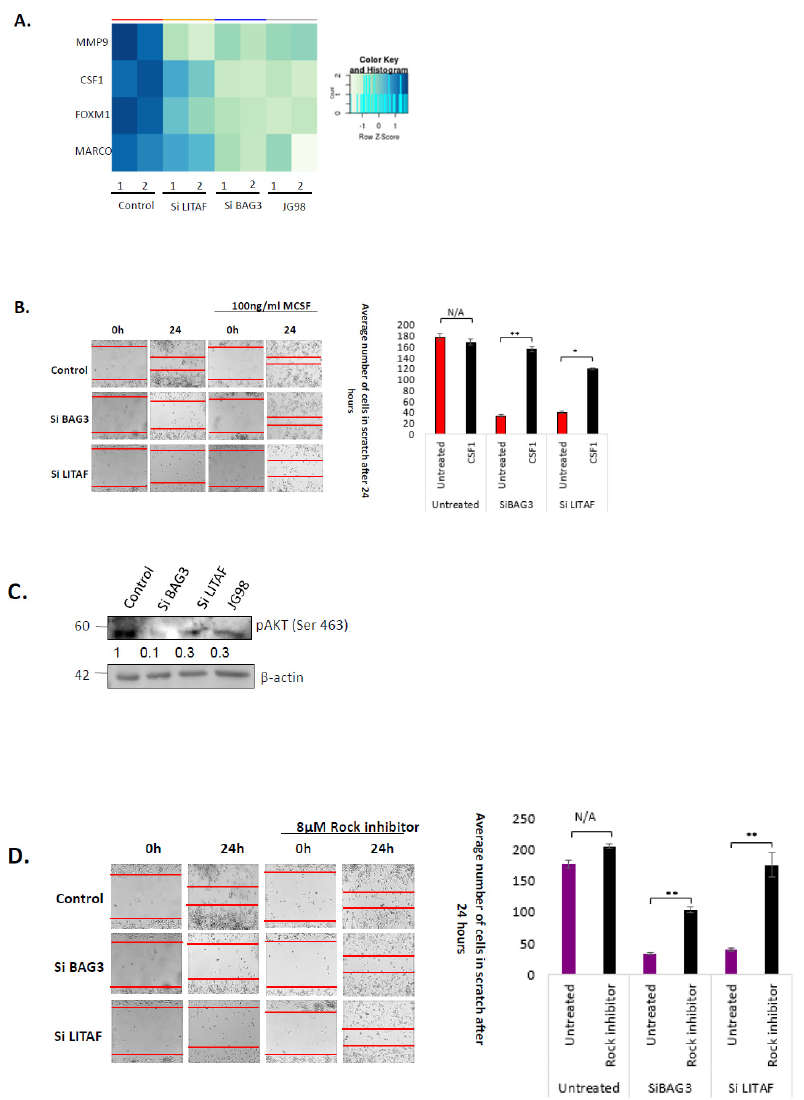
Figure 5. Effects of Bag3 and LITAF on macrophage motility are mediated by CSF1. ( A ) Effects of silencing of Bag3 or LITAF or inhibition of Hsp70 on the expression of motility-related genes. RNA was isolated from macrophages that were treated with siBAG3, siLITAF, control siRNA, or 5 µ M JG98, and gene expression was assessed by RNAseq. Genes related to motility/migration are shown. The figure presents data from two independent experiments. Color coding shows a False Discovery Rate (FDR). ( B ) The addition of CSF1 significantly restores cell motility upon silencing of Bag3 or LITAF. Differentiated THP1 macrophages were transfected with indicated siRNAs for 72 h, followed by incubation with 100 ng/mL CSF1. The bar graph on the right represents the calculation of the number of cells. Quantification was done via Student’s t -test statistic. ** p < 0.01, * p < 0.5. ( C ) Silencing of Bag3 or LITAF or inhibition of Hsp70 caused dephosphorylation of CSF1 downstream target Akt Ser463. Differentiated THP1 macrophages were transfected with BAG3, LITAF, or control siRNAs for 72 h or treated with 5 µ M JG98 for 24 h. Levels of indicated proteins were detected by immunoblot analysis. ( D ) Inhibition of the Akt target ROCK restores cell motility upon silencing of Bag3 or LITAF. A total of 8 µ M ROCK inhibitor was incubated with cells for 24 h and macrophage migration was monitored in the “wound healing” assay. ( Left panel ) assay as described in Figure 5B. Right panel —quantification of the migration data using Anova. Data shown are means+/SEM of triplicates. ** p ≤ 0.01. Uncropped WB Figure